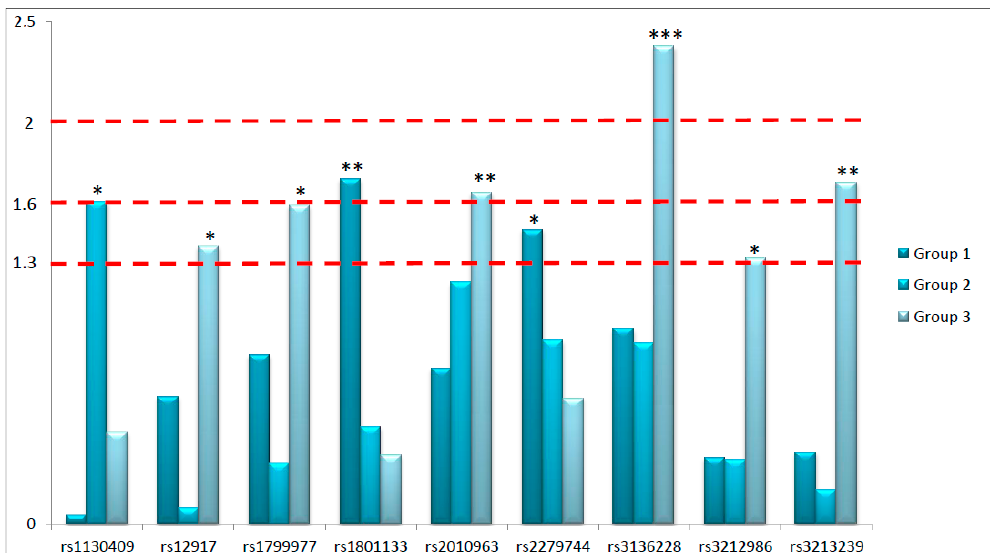
Figure 1. Graphical representation of the negative logarithms of the p -values ( Y -axis) of the single nucleotide polymorphisms (SNPs) resulted significant in at least one group of patients. Predictive biomarkers were classified into those with the strongest association ( p < 0.01), evidenced by three stars (***); those robustly associated ( p < 0.025), with two stars (**); and those significantly associated with treatment response ( p < 0.05), with one star (*). Dash lines were traced according to the selected thresholds of p